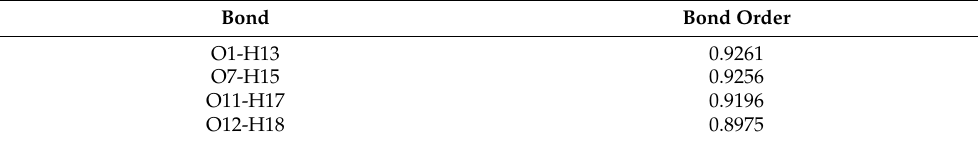
Table 1. Bond order values of GA.